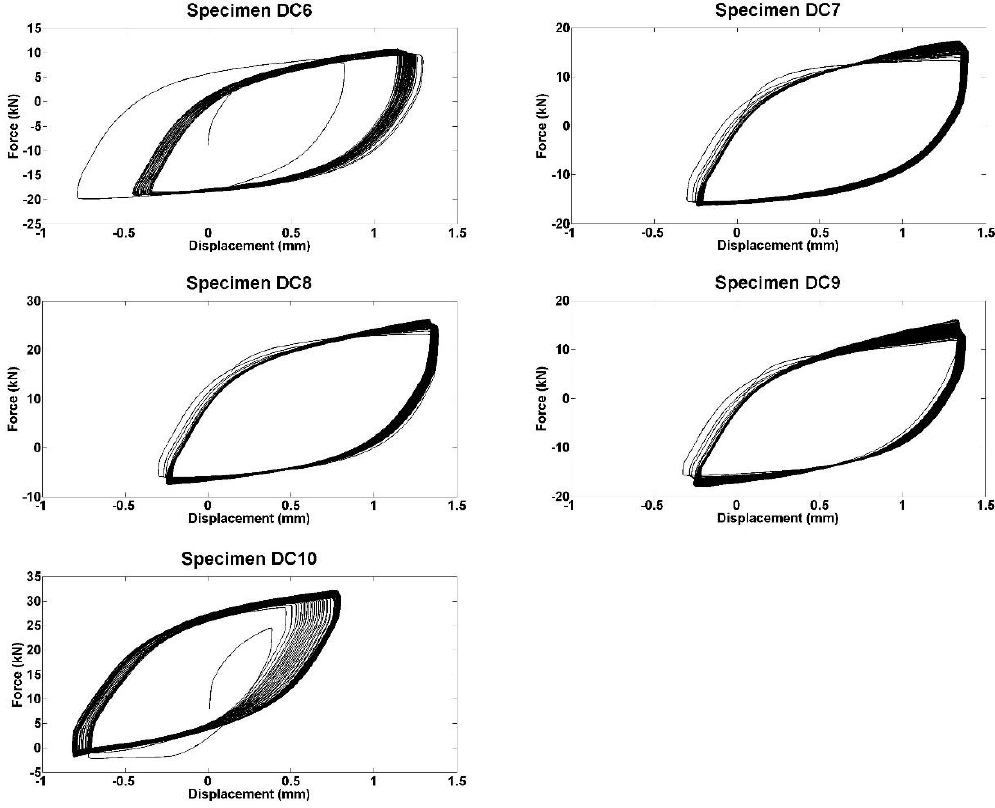
Figure 13. Typical hysteresis curves obtained from the tests of specimens DC6 to DC10. Table 3 Mechanical index of damage ID.